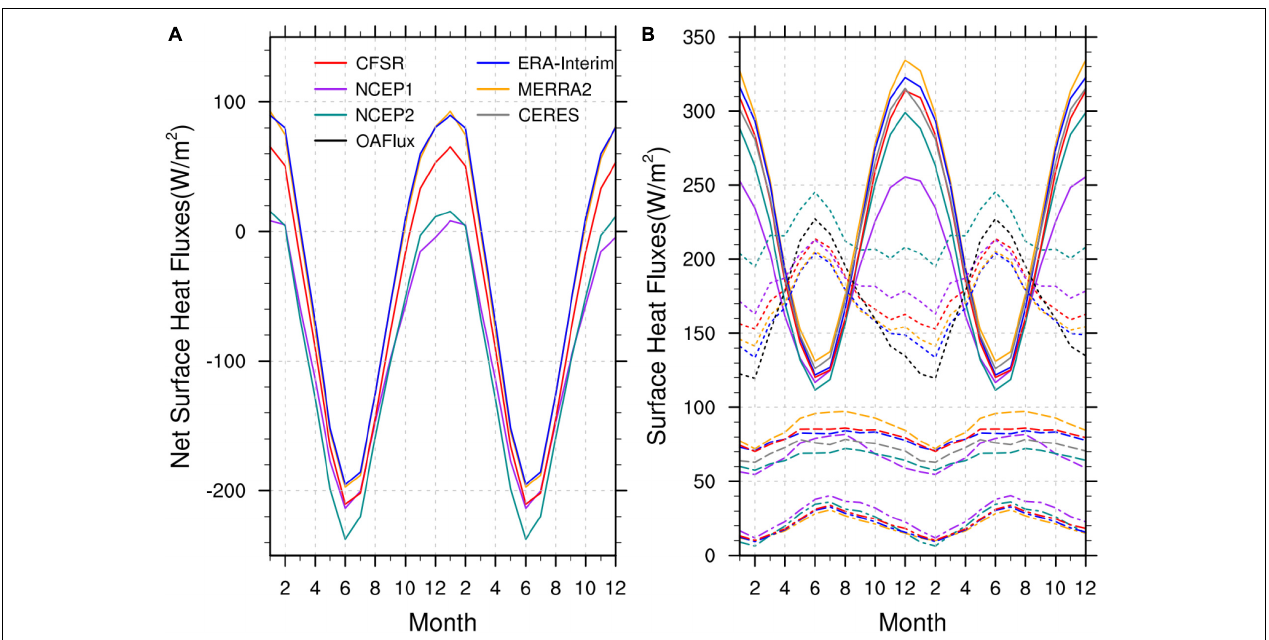
FIGURE 2 | (A) Climatological seasonal cycle of the net surface heat flux calculated for the area around the west coast of Australia (110 ◦ E-116 ◦ E, 22 ◦ S-32 ◦ S). (B) Same as in (A) , but for net shortwave radiation (solid line), net longwave radiation (dashed line), latent heat flux (dotted line) and sensible heat flux (dot-dashed line). Colors indicate different datasets. Positive values indicate the flux into the ocean (atmosphere) for net surface heat flux and shortwave radiation (longwave radiation, latent and sensible heat